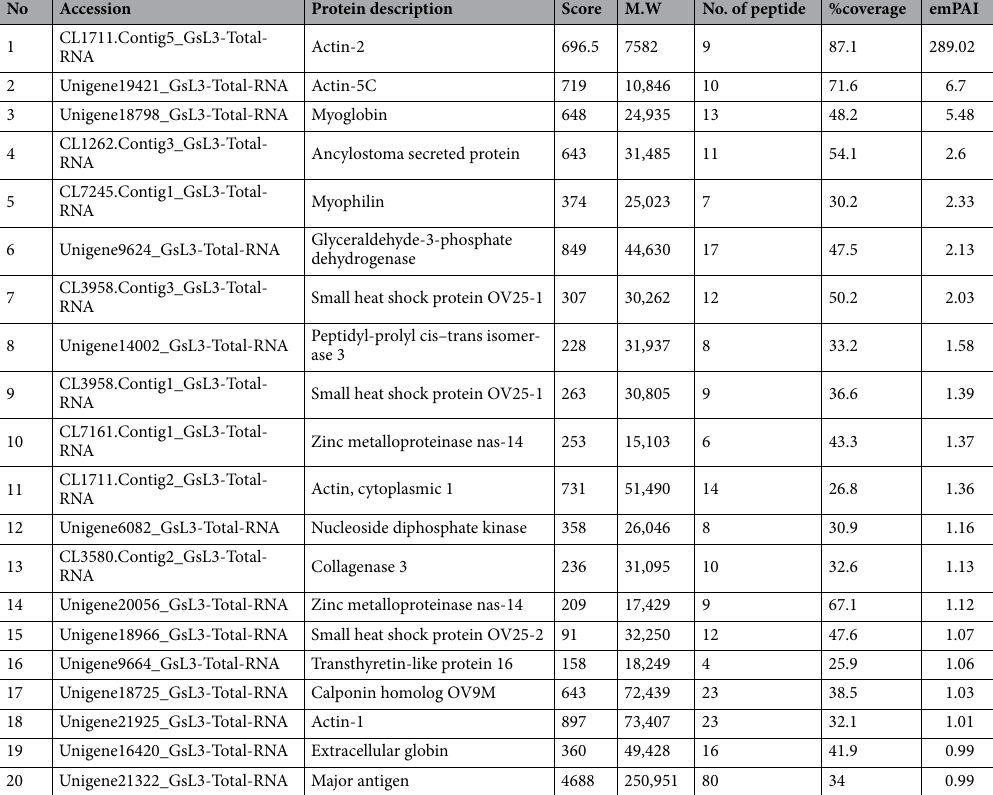
Table 1. List of the top-20 most abundant proteins in aL3Gs determined based on emPAI